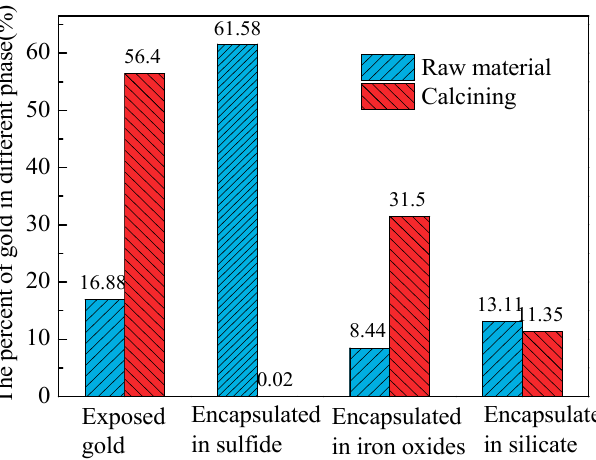
Figure 11. The occurrence of gold in different phases of Carlin-Type gold ore and calcine.